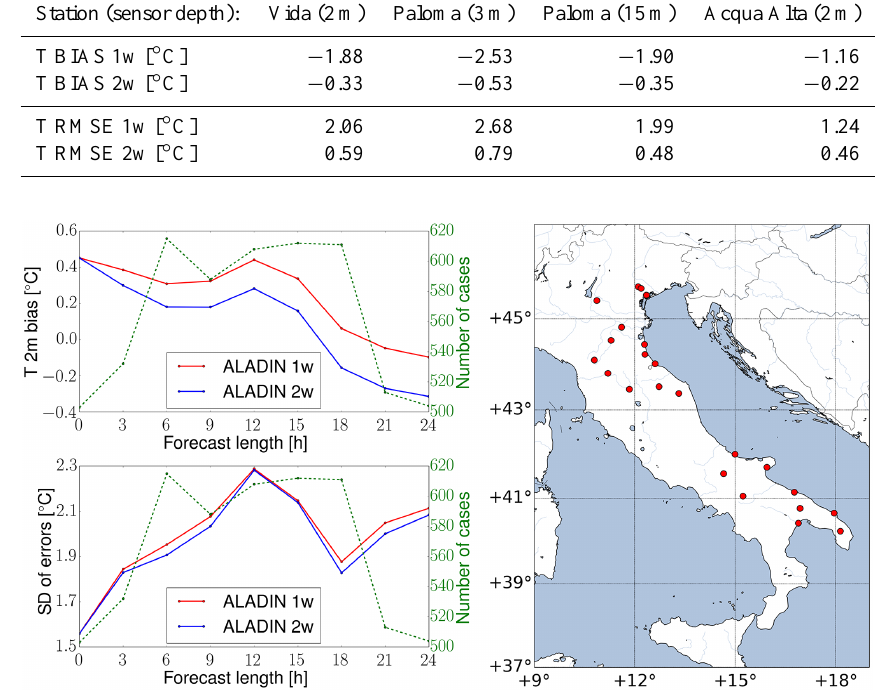
Figure 10. Left panel: bias (top) and standard deviation of errors (bottom) scores for ALADIN1w (red curve) and ALADIN2w (blue curve), depending on forecast length for temperature at 2m in February 2012. The green curve, quantified by the right-hand axis, depicts the number of cases (available number of measurements at all stations at each forecast hour combined) used in the statistics. Right panel: red circles mark the geographical locations of all 23 meteorological stations used for